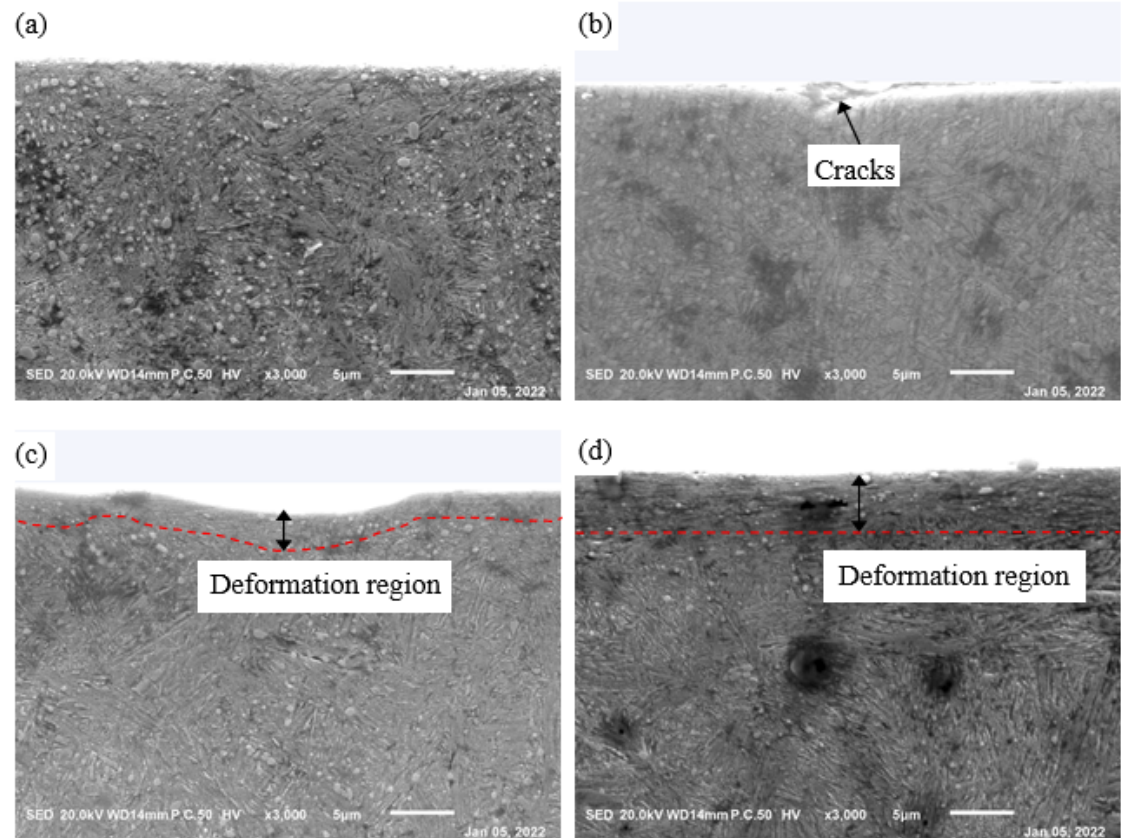
Figure 13. Morphologies under worn surfaces of the steels austempered at different temperatures for 8 h: ( a ) GCr15SiMo at 210 °C; ( b ) GCr15Si1Mo at 210 °C; ( c ) GCr15SiMo at 230 °C; ( d ) GCr15Si1Mo at 230 °C.